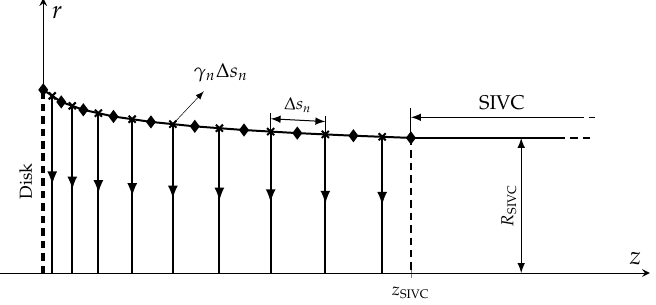
Figure 3. Sketch of the rotor vortex